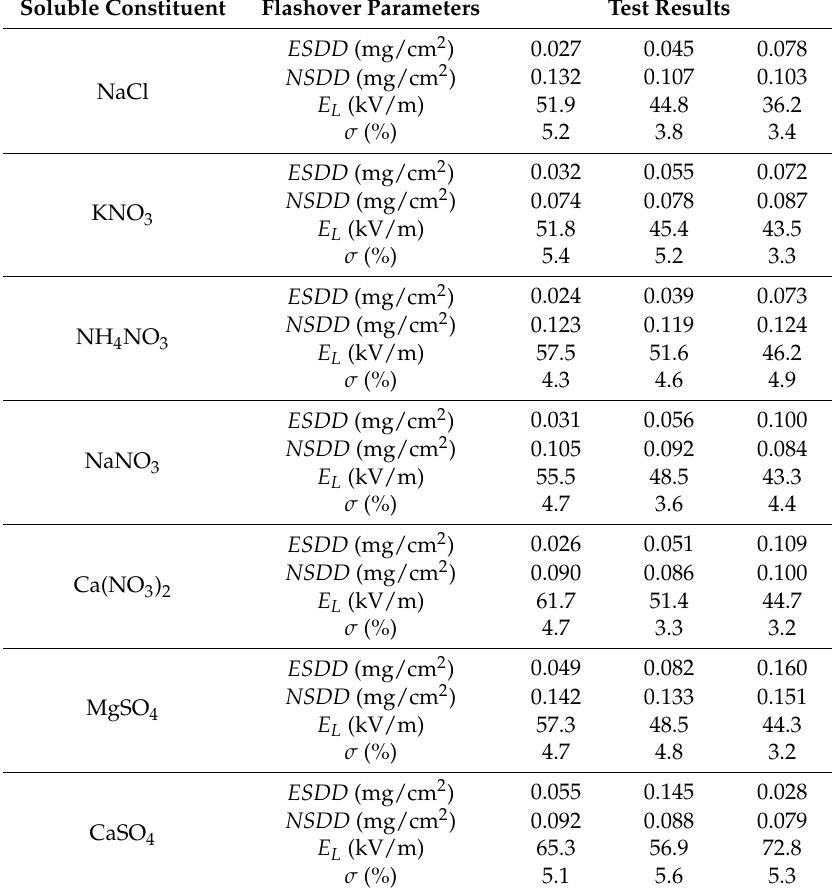
Table 4. Test results of insulator strings polluted with different soluble constituents. Soluble